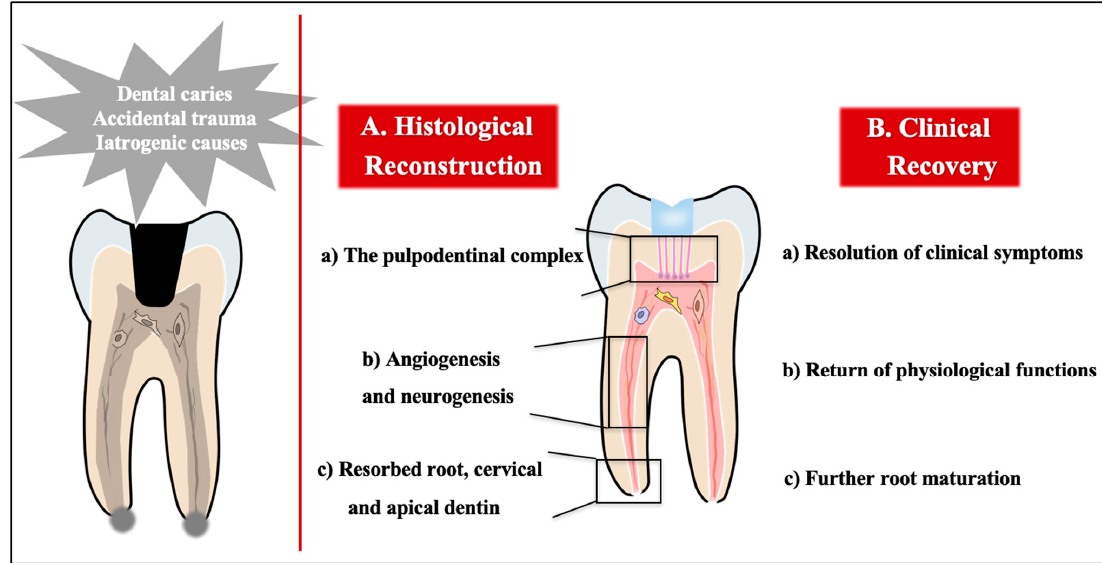
Figure 1. Histological and clinical goals of pulp regeneration. Dental pulp may be damaged by dental caries, accidental trauma, or iatrogenic causes. The success of pulp regeneration should be defined by ( A ) histological and ( B ) clinical measures. Reconstruction of the pulpodentinal complex through angiogenesis and neurogenesis could yield histologically successful regeneration following cervical and apical dentin formation. Clinical success includes elimination of clinical symptoms such as pain and bone resorption, return of physiological functions, and increased root wall thickness and/or increased root length.